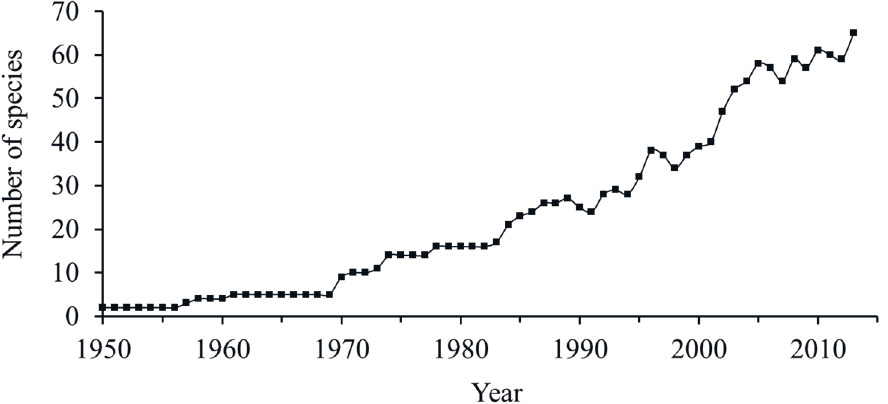
Figure 4. Evolution of the number of marine fish species farmed per